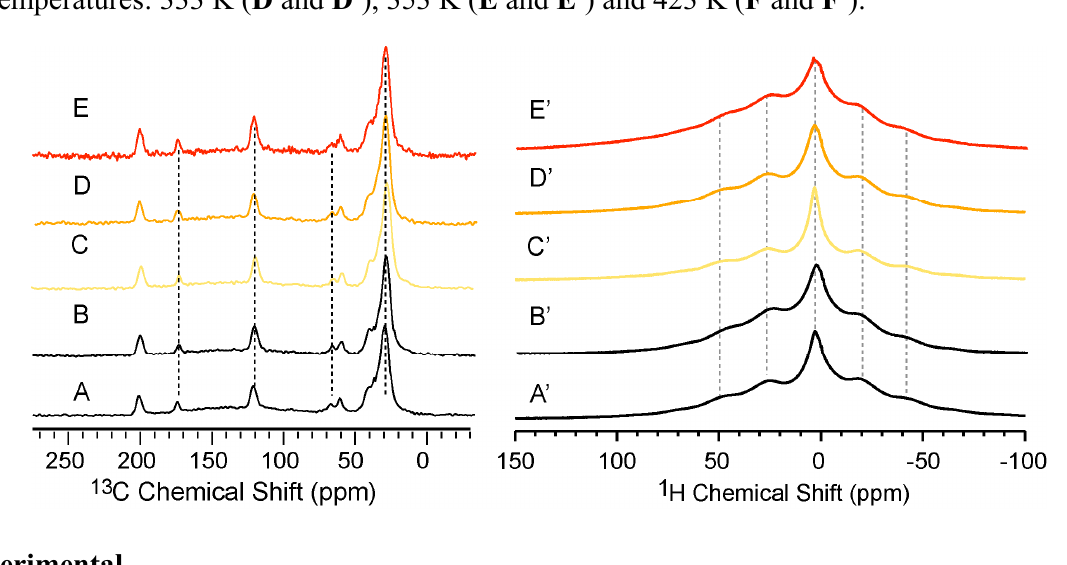
Figure 6. 13 C CP/MAS (left panel) and 1 H (right panel) spectra of NPBA after acetone treatment or aging. ( A and A' ) NPBA without further treatments as the control spectrum. ( B and B' ) Acetone-treated NPBA. ( C – E and C' – E' ) NPBA aged for 16 h at different temperatures: 333 K ( D and D' ), 353 K ( E and E' ) and 423 K ( F and F'